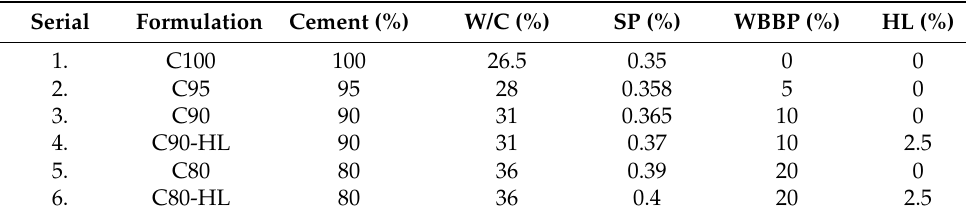
Table 1. Self-compacting paste